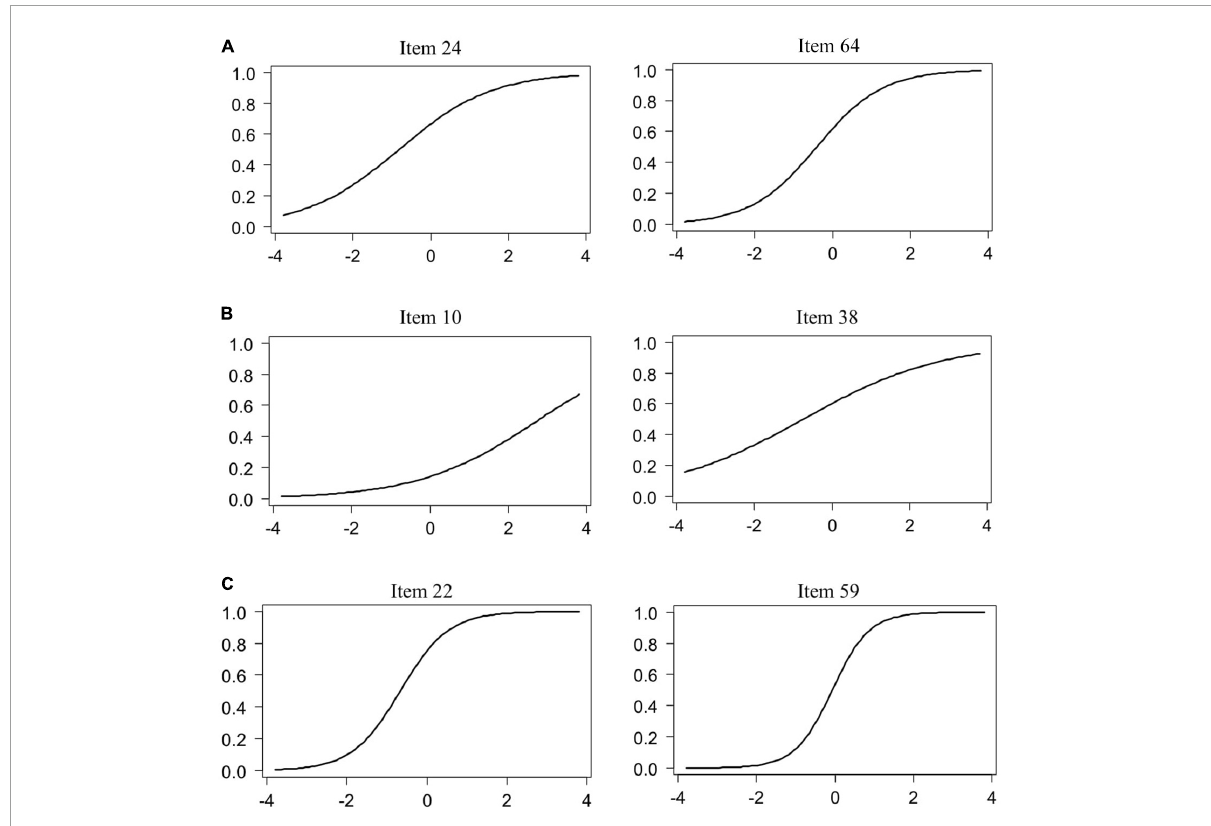
FIGURE6 Comparison of item characteristic curves (ICCs) in different subjects. (A) ICCs of Item 24 (“When I found unclear points while learning mathematics, I asked my friends and teachers”) and Item 64 (“When I found unclear points when learning science, I asked my friends and teacher”). (B) ICCs of Item 10 (“When I learned English, I read English text in books, magazines, or newspapers”) and Item 38 (“When I learned social science, I read books or articles on topics I found interesting”). (C) ICCs of Item 22 (“When I learned mathematics, I tried to consider why I failed to solve problems”) and Item 59 (“When I learned science, I tried to consider why I failed to solve